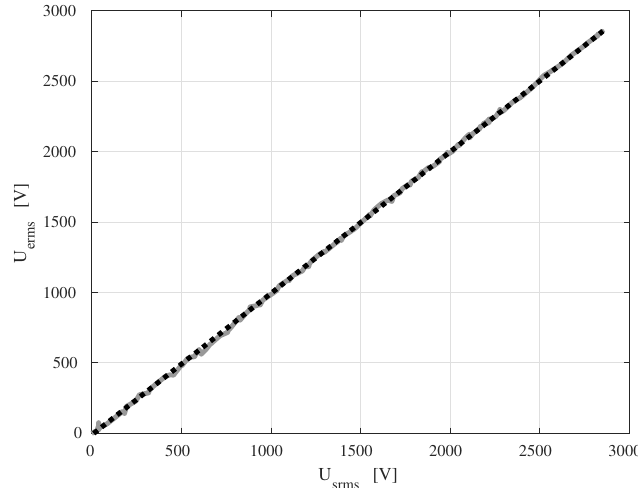
Figure 11. Input–output characteristic of the sensor in a range between 0 and 3 kV RMS (gray). The dotted black line is a linear interpolation of a characteristic.